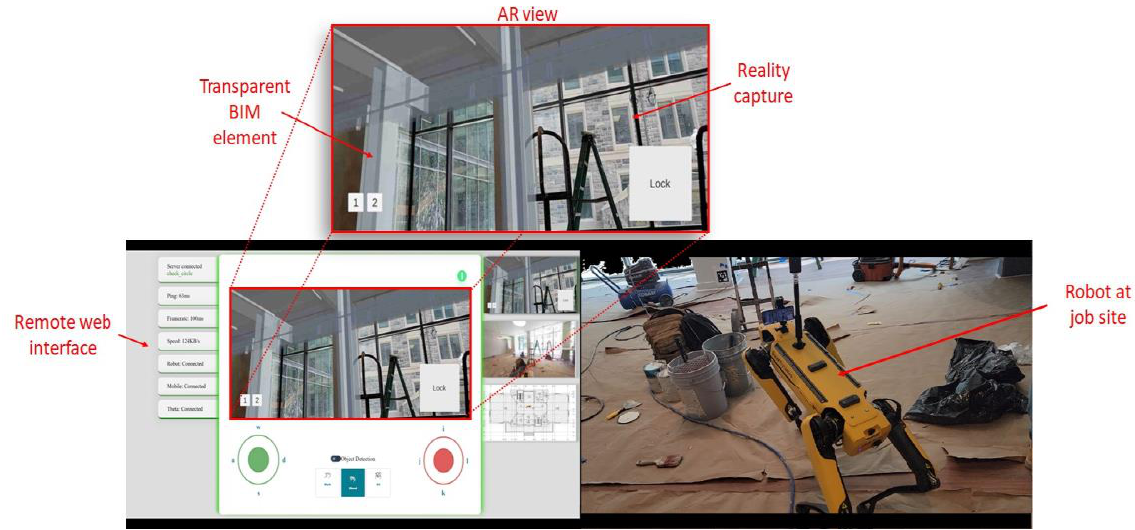
Figure 14. Snapshot of the experiment in use case 2.